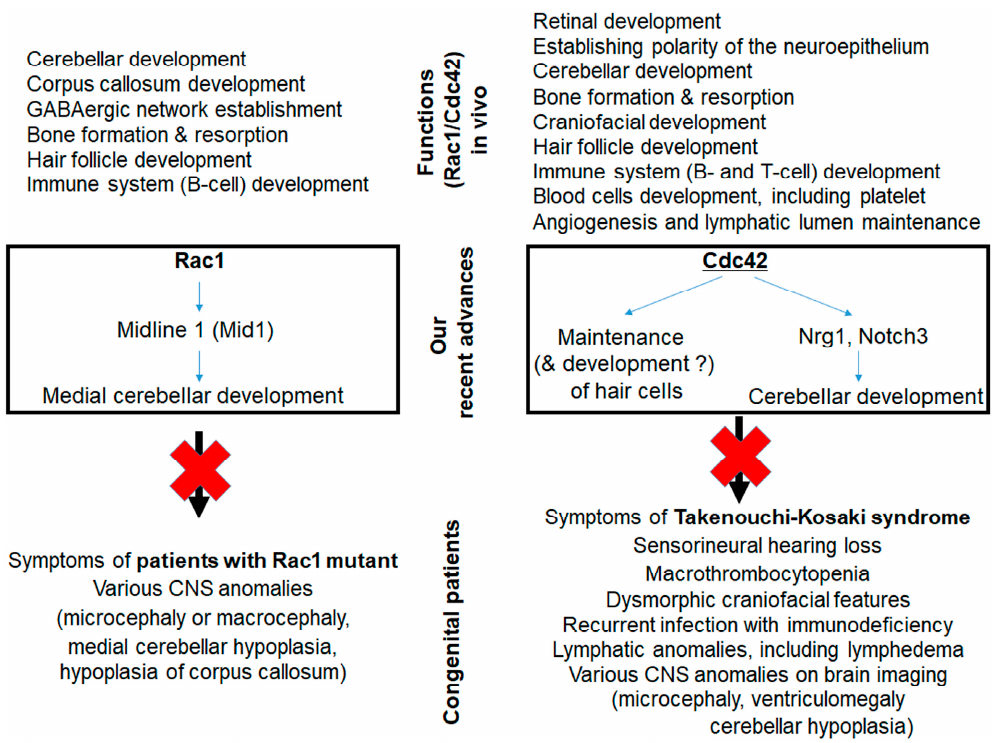
Figure 2. Functions of Rac1 ( left ) or Cdc42 ( right ) in vivo ( upper ), our recent advances using Rac - [66] or Cdc42 -KO [57,71] mice ( middle ), and congenital/hereditary patients with RAC1 or CDC42 mutants ( lower ). Evidence from animal models helps elucidate the functions of Rac1 [66–69,72–78] and Cdc42 [71,74,79–93] and the symptoms of congenital/hereditary patients with mutations in RAC1 [20] and CDC42 [29–32] . Nrg1: neuregulin